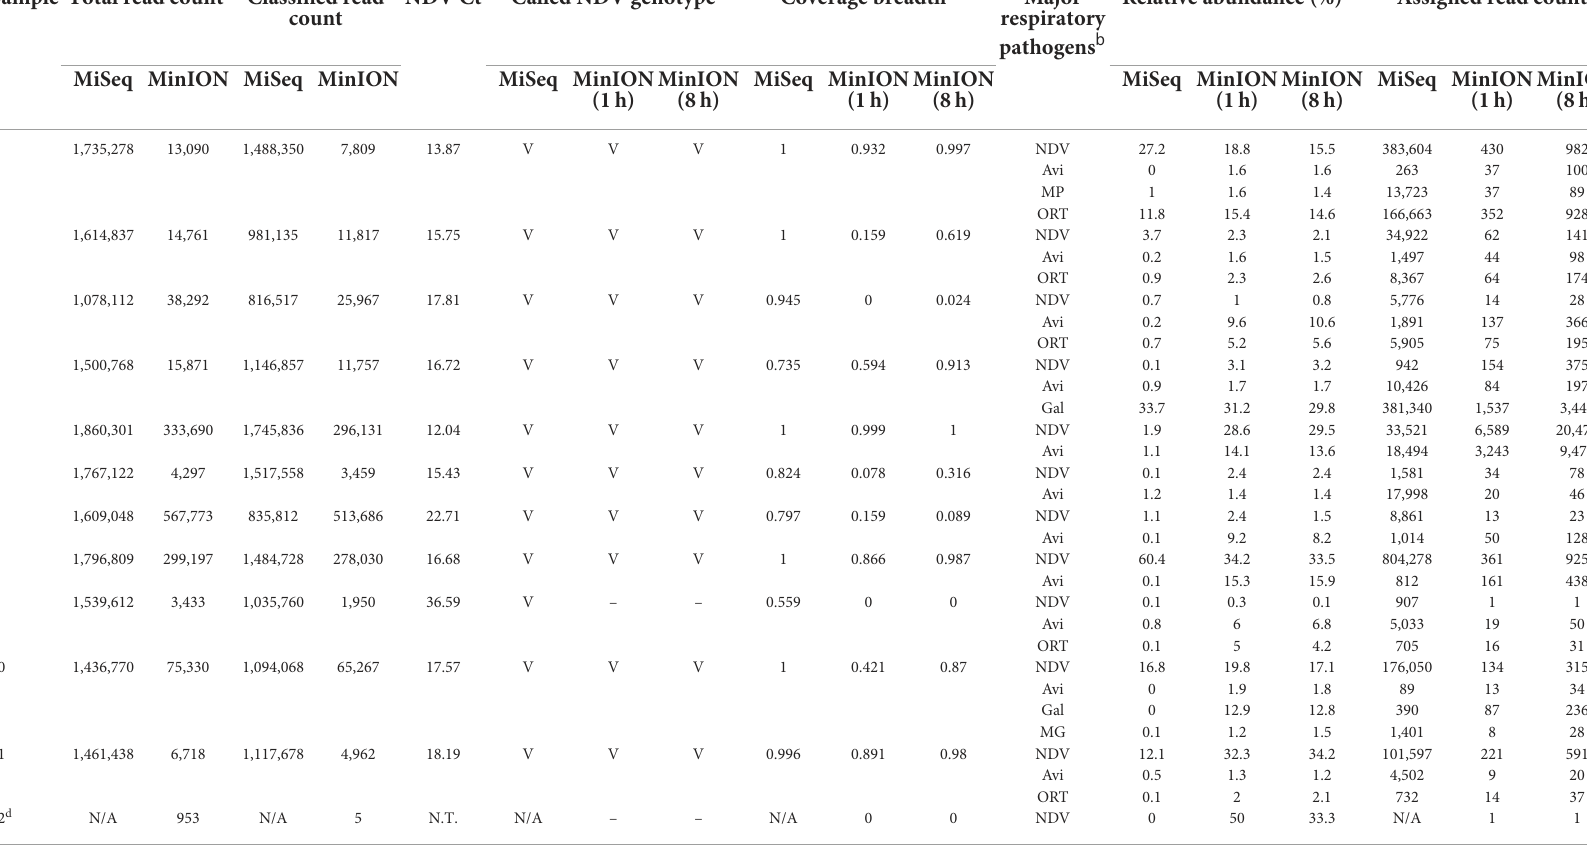
TABLE 1 Pathogen identification from MinION and MiSeq sequencing from clinical samples collected from Kenya. Sample Total read count Classified read